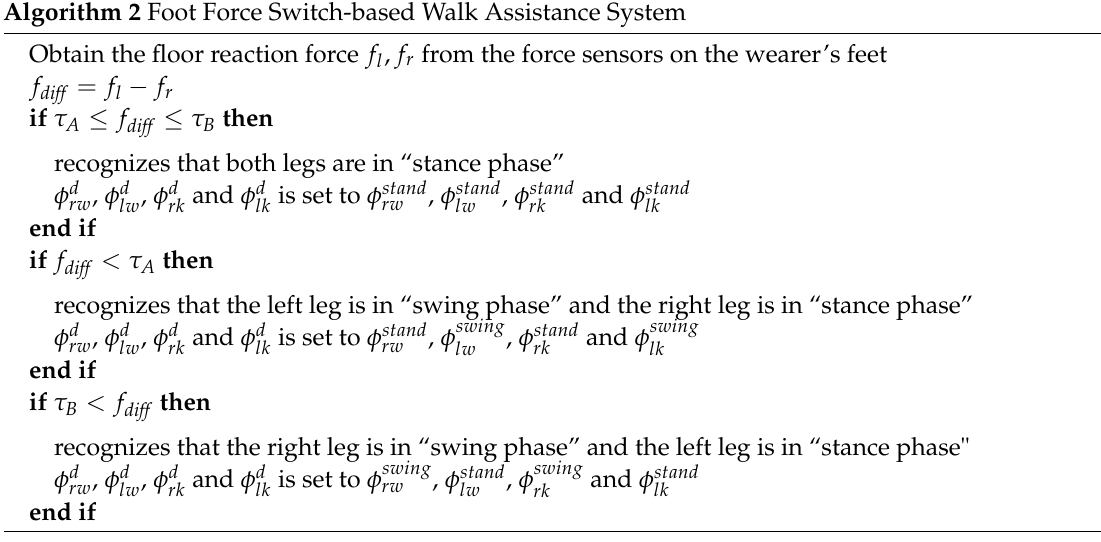
Algorithm 2 Foot Force Switch-based Walk Assistance